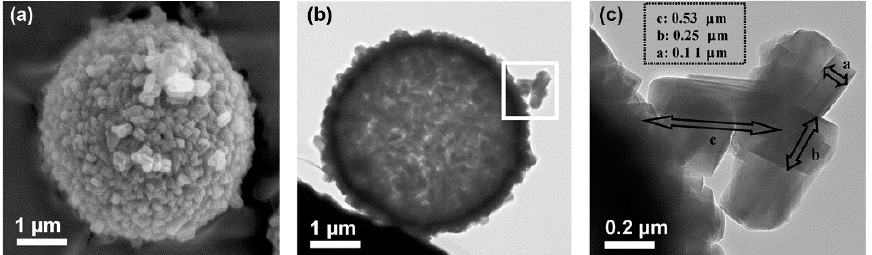
Figure 4. Structural morphology of HZSs, showing the ( a ) scanning electron microscopic (SEM), ( b ) transmission electron microscopic (TEM) images, and ( c ) the silicalite-1 crystals on the shell of the hollow sphere. Reprinted with permission from ref. [77] . Copyright 2011 Elsevier.